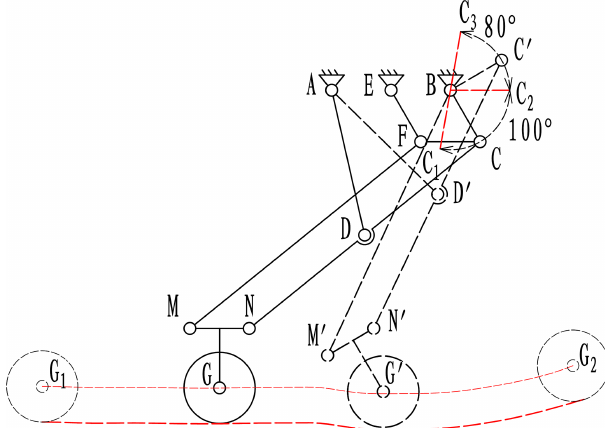
Figure 4. Schematic diagram of the multi-link